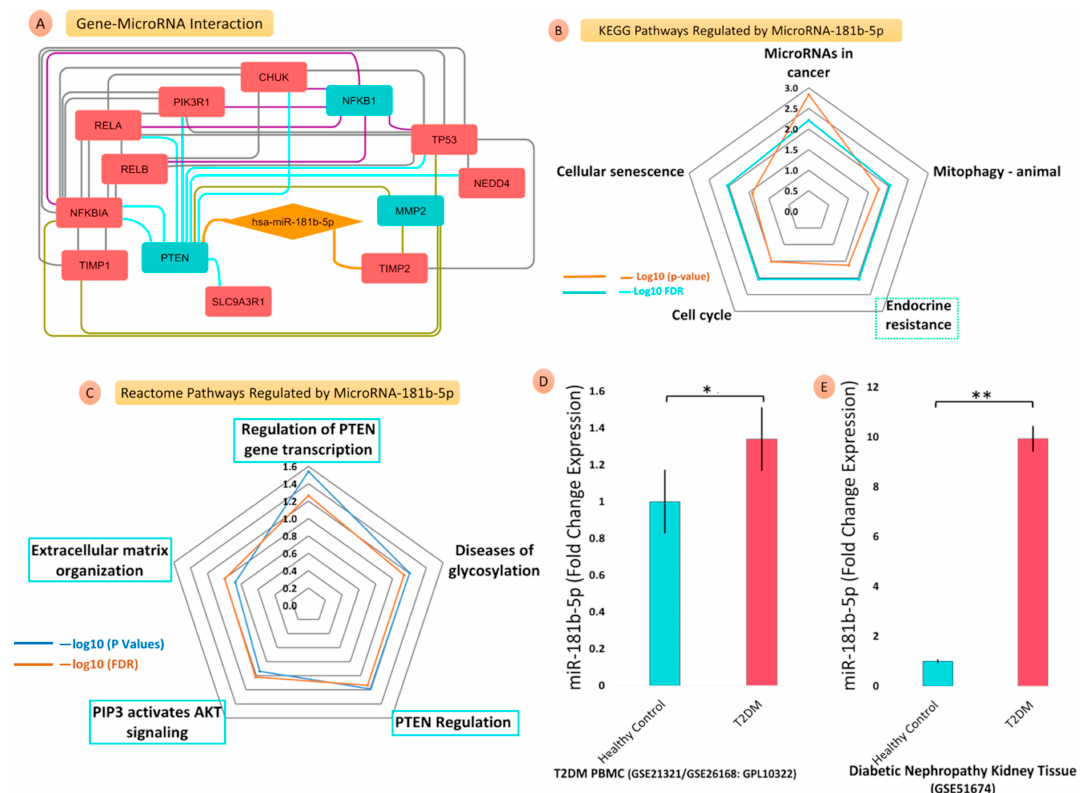
Figure 6. Gene–microRNA interaction, microRNA-regulated pathway enrichment, and validations using GEO microRNA–microarray datasets. The gene–microRNA interaction diagram ( A ) shows the direct target genes, PTEN and TIMP2, of hsa-miR-181b-5p; the radar plot (values: − log10 FDR) represents the significant ( B ) KEGG pathways and ( C ) reactome pathways regulated by miR-181b-5p; the bar graphs show the comparative FCs of miR-181b-5p for T2DM, PBMC, and DN kidney tissues datasets. Bar graphs show the comparative FCs of miR-181b-5p in ( D ) PBMC of T2DM datasets (GSE21321/GSE26168: GLP10322) and ( E ) Diabetic nephropathy kidney tissue datasets (GSE51674) (** ≤ 0.05; * ≤ 0.001).